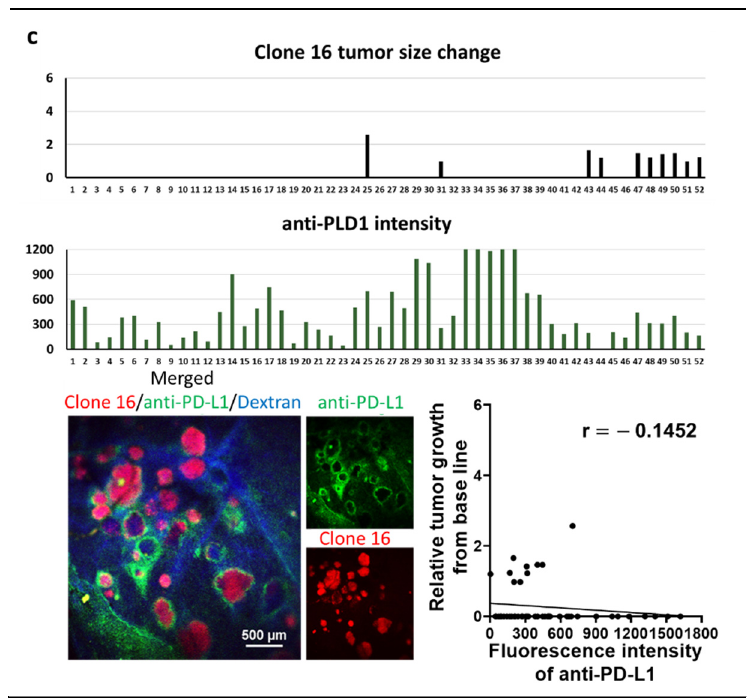
Figure 3. Intravital microscopy (IVM) imaging of liver metastasis of 4T1 parental ( a ), clone 1 or clone 16 cells treated with anti-PD-L1 IgG therapy through a window chamber for 7 days ( b , c ). IVM imaging of liver metastases originated by 4T1 parental, clone 1, or clone 16 cells (red) through a window chamber. Fluorescently labeled anti-PD-L1 IgG (200 µ g/kg) was iv injected, and the fluorescence intensity of accumulated IgG in tumors was measured 6 h after injection. Mice were then further treated with non-labeled anti-PD-L1 IgG (15 mg/kg) and imaged for an additional 7 days. Tumor size change was calculated based on the measurement of tumor diameter prior to and seven days after therapy. Scattergrams showed the correlation between tumor size change and the amount of delivered anti-PD-L1 IgG in each